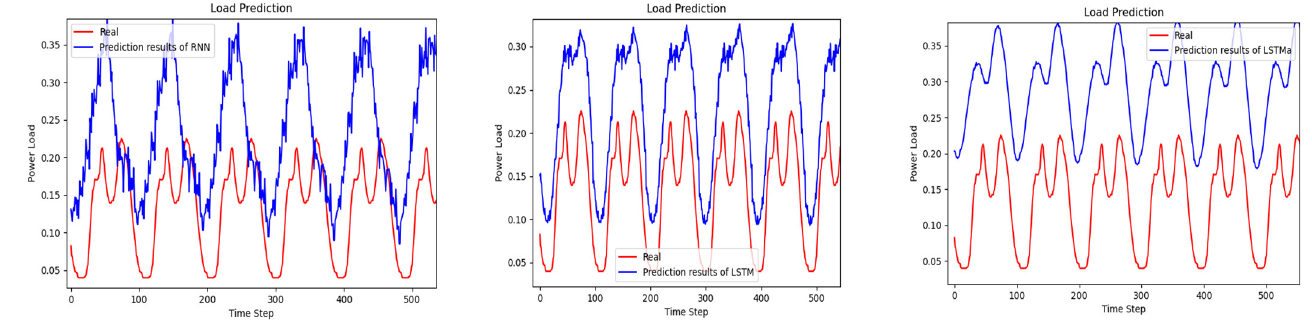
Figure 10. Prediction results of the model based on RNN in 500 time steps.